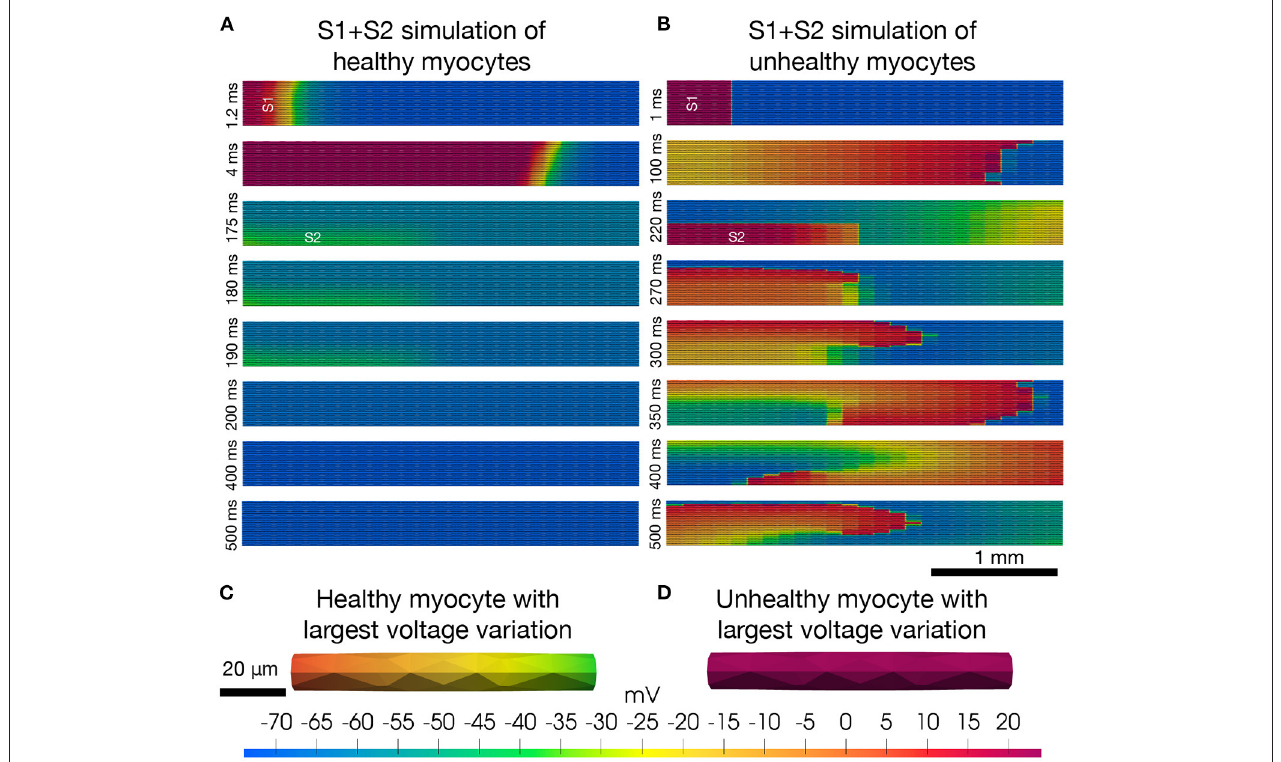
FIGURE 2 | Re-entry in a cell-based model. The upper panels (A,B) show the results (intracellular potential) of S1 + S2 stimulations (see, e.g., Spach et al., 2007) of a collection of 25 × 25 myocytes. The simulations are started by stimulation of the four leftmost rows of cells (marked by S1) and a resulting depolarization wave propagates through the tissue from left to right. After the center cell is repolarized to − 60 mV, the lower left quarter of cells (marked by S2) are stimulated, potentially initiating a second depolarization wave through the tissue. In the healthy case (A) , the S2 stimulation does not produce a second wave, whereas in the unhealthy case (B) , the solution evolves into to a stable re-entrant wave that continues indefinitely. In the lower panels ( C,D) , we show the solution of the single myocyte with the largest observed variation in intracellular potential during the simulation at the time point when the largest variation is observed. The maximum single cell variation is much larger in the healthy case (C) than in the unhealthy case (D)